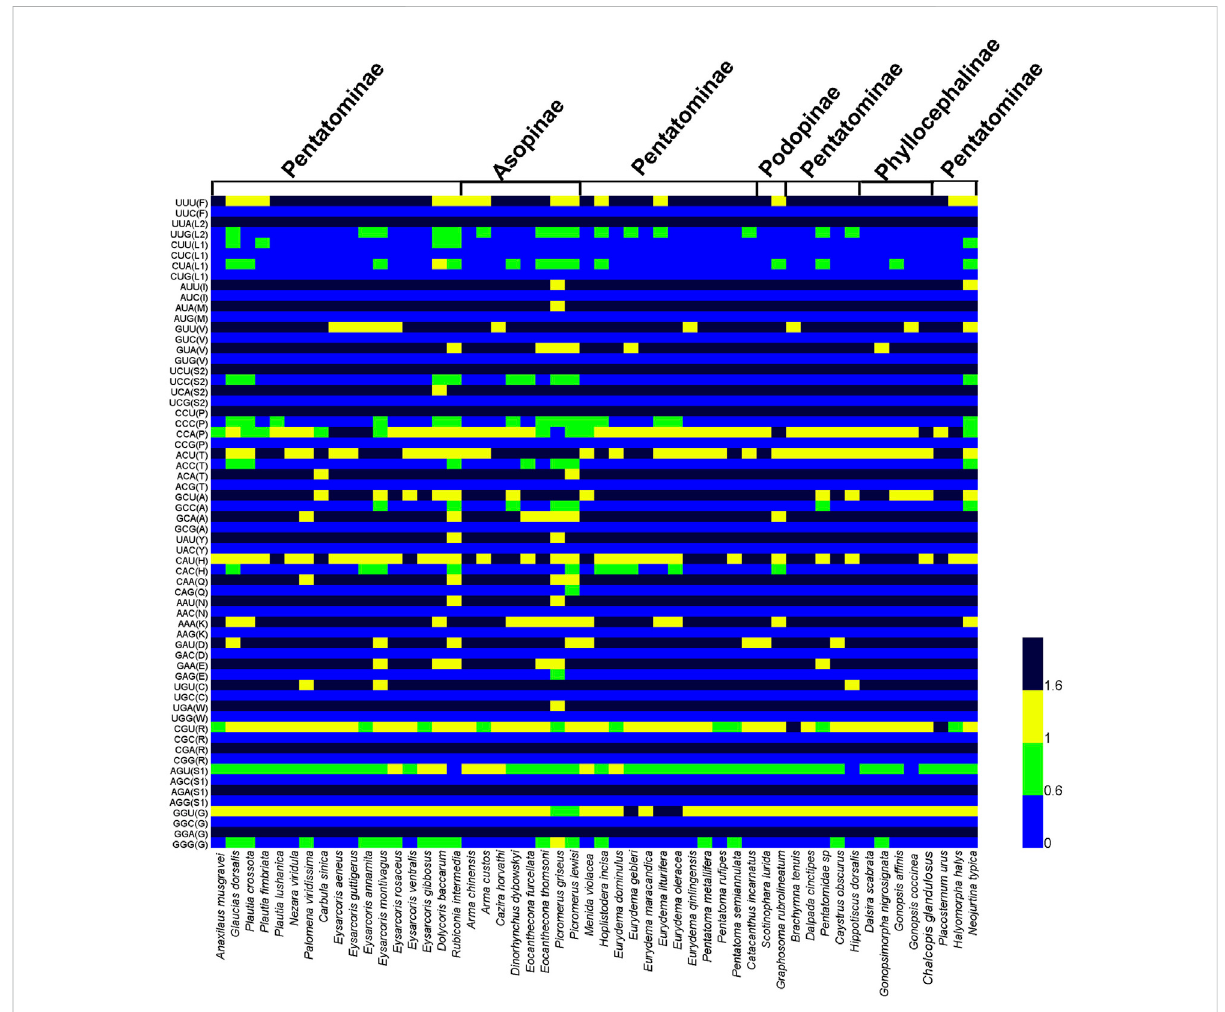
FIGURE 2 Heatmap analysis of relative synonymous codon usage (RSCU) values among the 53 species of Pentatomidae.